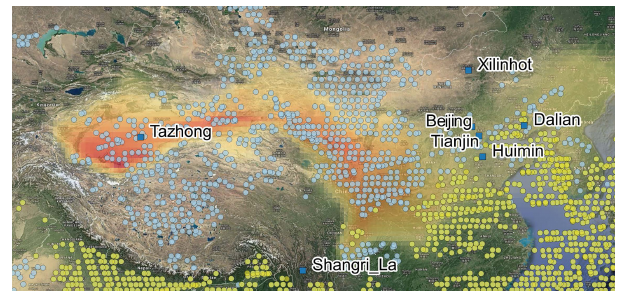
Figure 1. Desert dust event forecast by the CAMS system for 9 March 2013 (shaded) with observation locations from the Dark Target (yellow dots) and the Deep Blue algorithms (blue dots) from MODIS Collection 6 used in the assimilation experiments. A few in situ verification stations are also highlighted. For these stations detailed results are provided.